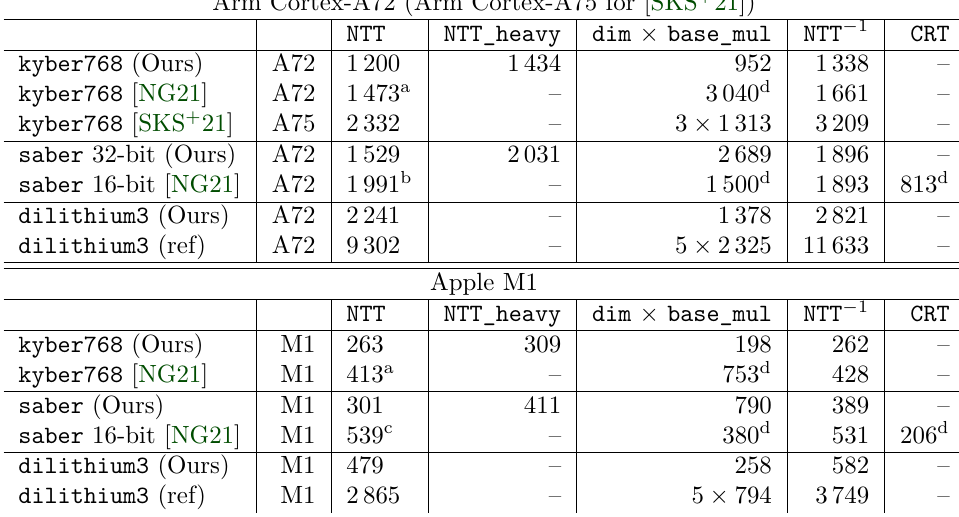
Table 4: Performance results for NTT , NTT_heavy , base_mul , and NTT − 1 for kyber768 , saber , and dilithium3 on Cortex-A72 and Apple M1. dim refers to the module